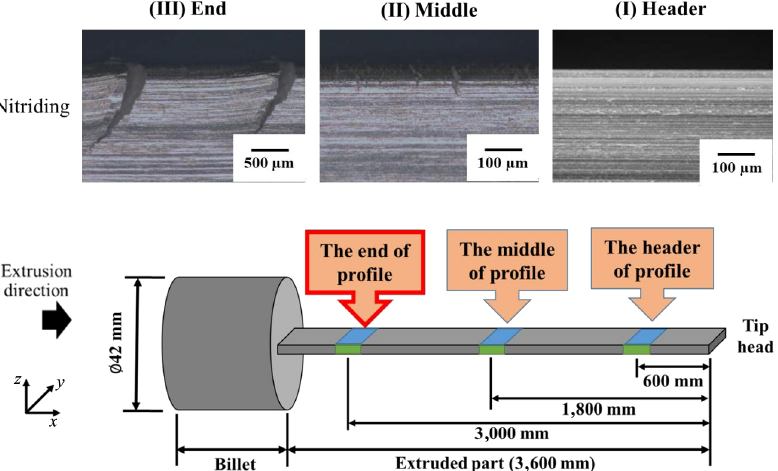
Fig. 10 Surface appearance of extruded material at difference distances from the tip head by z -axis view: (I) 600 mm, (II) 1,800 mm, and (III) 3,000 mm, extruded at the temperature of 450 °C with the extrusion speed of 1.0 mm/s. The die was coated using